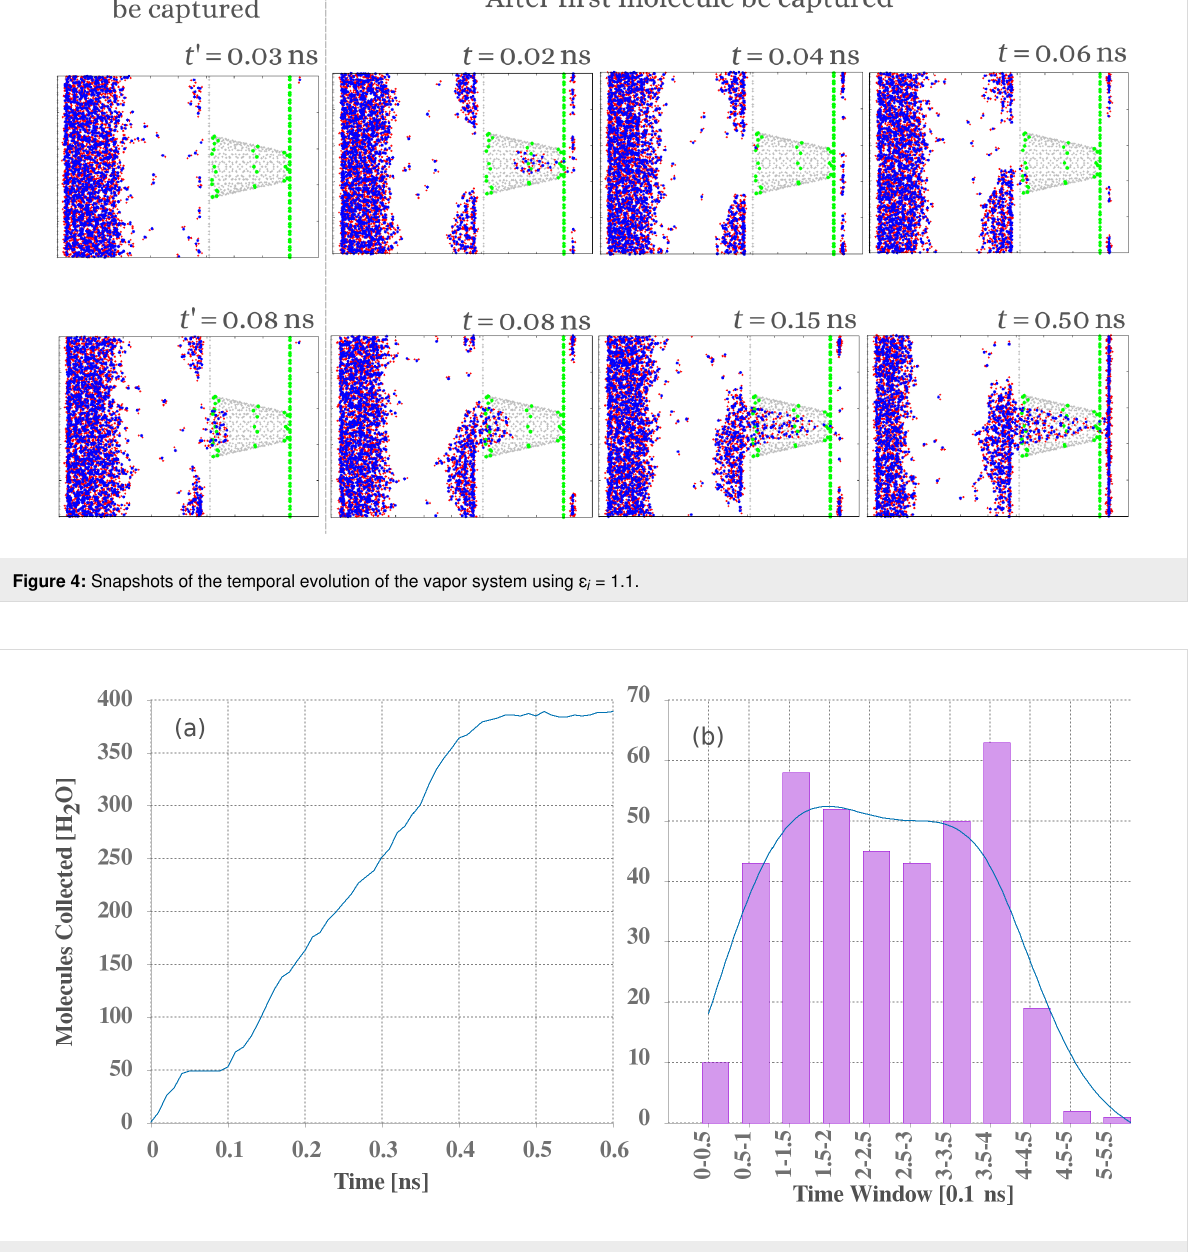
the wettability of the hydrophilic slab ( ε r = 1.1). Without that, no molecule would have been captured. In the case of the com- pletely hydrophobic nanocone, no droplet is formed in the base of the nanocone. Only very few molecules randomly enter and are successfully harvested, but this number is negligible. In Figure 6 (bottom right), we also present a 3D snapshot for t = 0.37 ns to demonstrate that there are no molecules at the entrance of the